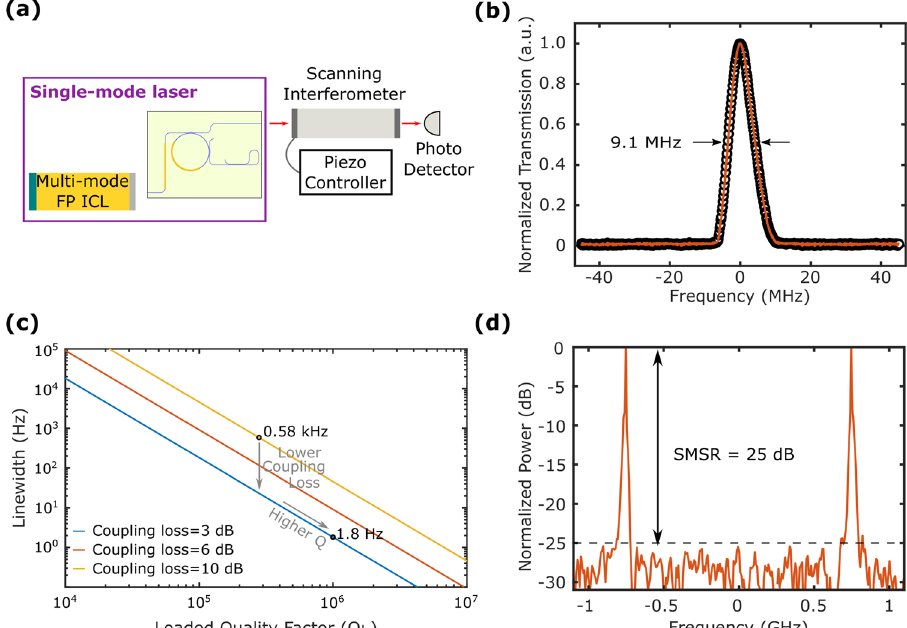
Fig. 6 Linewidth and side mode suppression ratio (SMSR) of the locked-state laser. a Linewidth measurement setup. b Measured linewidth of 9.1 MHz limited by the resolution of the scanning Fabry – Perot (FP) interferometer. c Calculated fundamental linewidth versus loaded quality factor ( Q L ) for 0.4 mW output power. About two orders of magnitude improvement can be achieved with higher Q L of the microresonator and improved coupling between the Interband Cascade Laser (ICL) and the silicon chip. d Measured SMSR of 25 dB. The FP interferometer resonance is scanned over one free-spectral range (FSR) with a piezoelectric